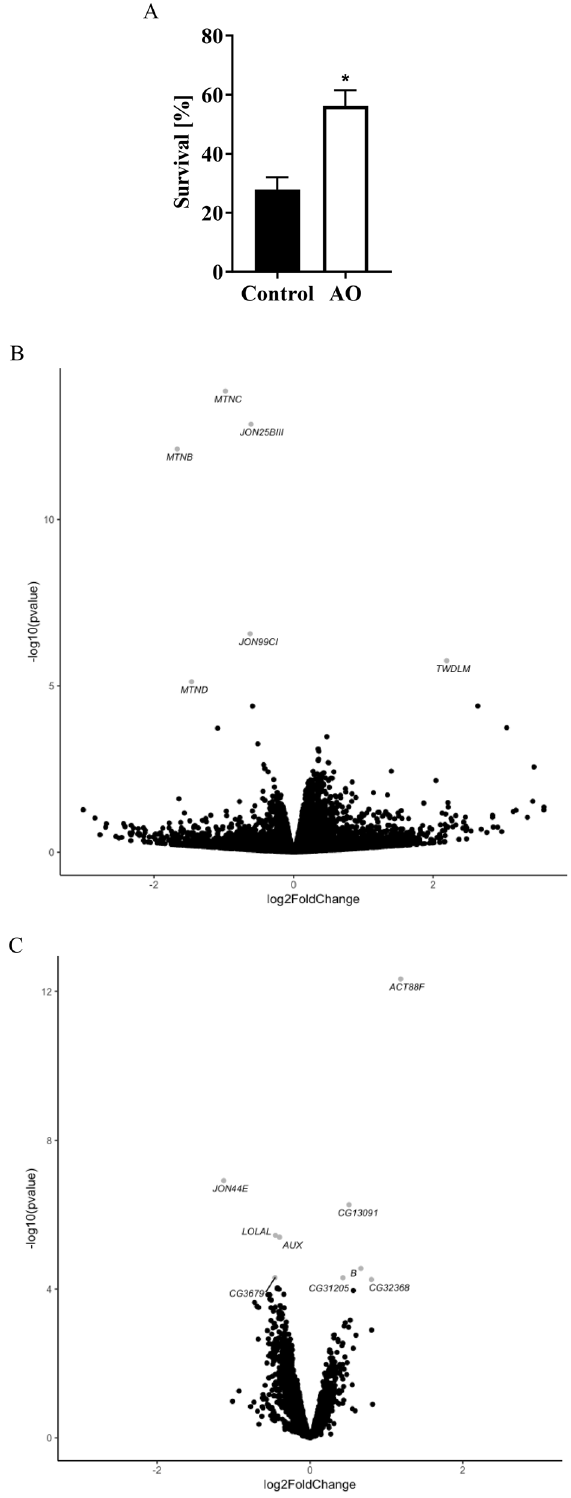
Figure 2. Survival ( A ) and differential gene expression profiles ( B , C ) of heat-stressed D. melanogaster flies maintained according to the feeding protocols C and AO. ( A ) Data are least square means ± SEM of flies survived the challenge of 39 °C heat exposure for 75 min after a subsequent recovery period of 24 h (*effect of AO, P < 0.0001). Results are from 9 independent experiments performed in two-to forth-fold determination with 18–22 flies per vial (N = 500 per condition). ( B , C ) Female, age-matched 10-day old D. melanogaster flies were placed in groups of 18–22 per vial containing control or AO medium and subsequently exposed to sub-lethal heat stress at 39 °C for 60 min. Data are log2 fold change of differentially expressed genes after ( B ) 60 min of heat stress (t 60 ) or ( C ) subsequent 180 min of recovery (t 240 ) from the challenge (n = 5/time point). Labeled, gray colored genes were affected by AO (adjusted P <